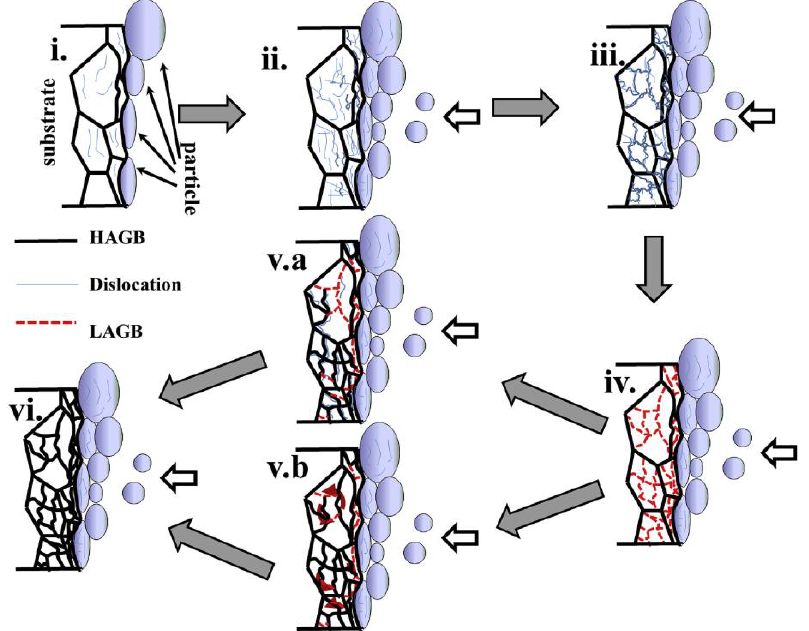
Figure 4. Schematic illustration of the microstructural evolution at the steel substrate near the interface between a CS coating and substrate: ( i ) deformation near the interface, ( ii ) dislocation accumulation at the interface, ( iii ) dislocation tangling and formation of cells, ( iv ) rearrangement and subgrain development, ( v.a ) HAGB formation due to dislocation accumulation from an LAGB, ( v.b ) an HAGB formed due to CDRX, and ( vi ) final microstructure of substrate are represented. Reprinted from Chaudhuri et al. [65], Copyright 2017, with permission from Elsevier.